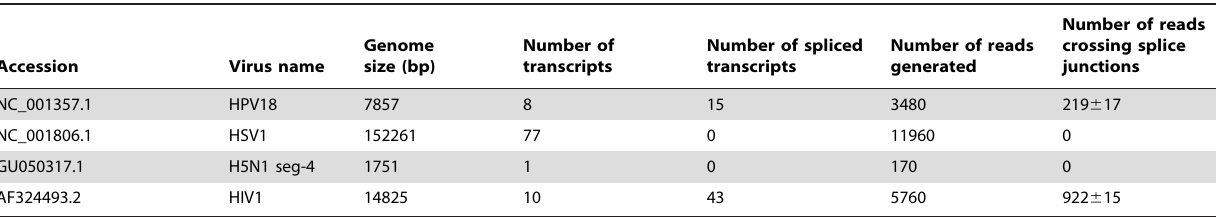
Table 2. Summary of data generated for each of the four viral